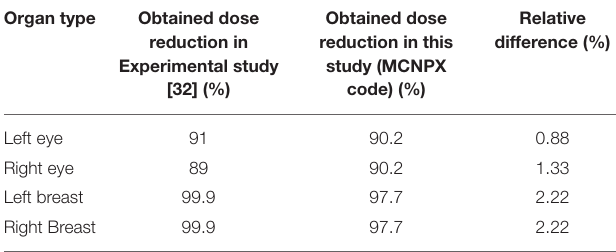
TABLE 2 | Comparison of obtained dose reductions between experimental and Monte Carlo study.